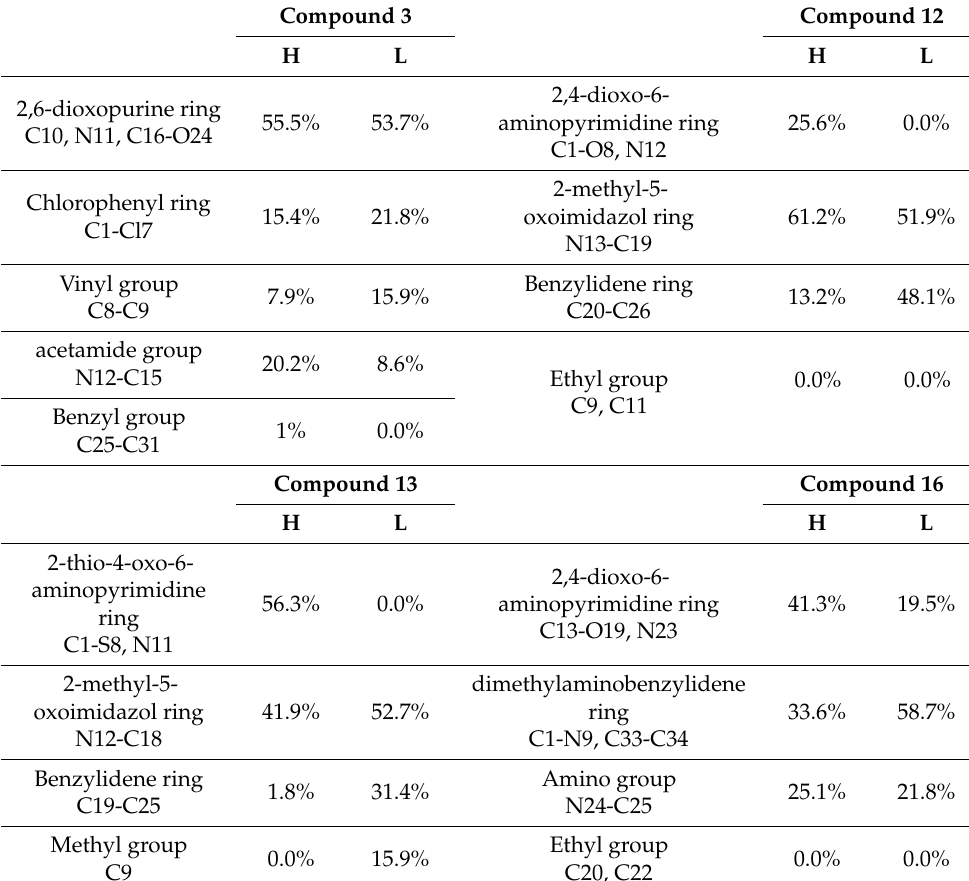
Table 7. Composition of the frontier molecular orbital for studied the compounds 3 , 12 , 13 and 16 by using